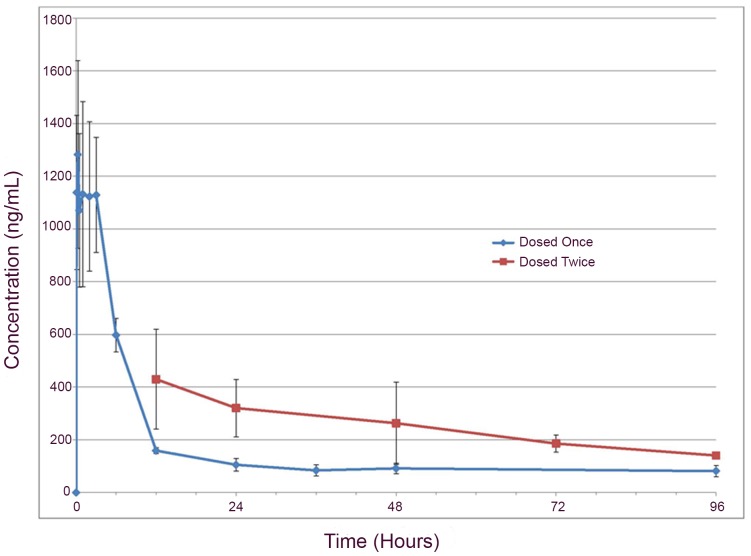
Pharmacokinetics of GM6001 in dogs.Administration of a single 100 mg/kg subcutaneous dose of GM6001 to dogs resulted in the rapid development of peak plasma drug concentrations with drug still detectable 96 hours post-delivery. Administration of a second dose of GM6001 to a sub-group of dogs 12 hours following initial drug delivery resulted in increased plasma drug concentrations at all assessed time points.